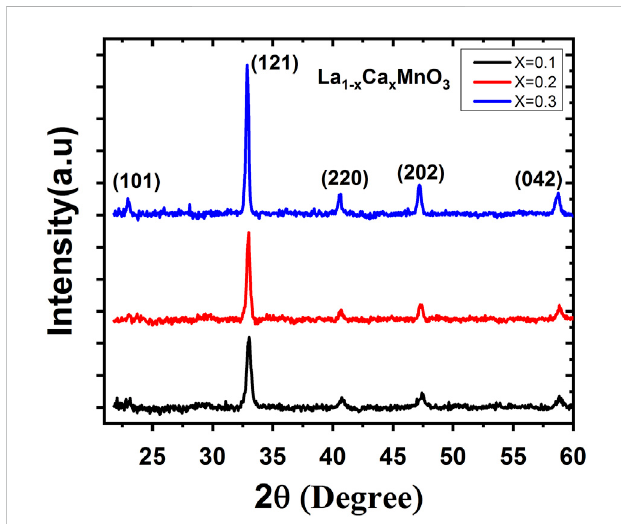
FIGURE 1 XRD pattern of La 1-x Ca x MnO 3 nanoparticles, where x = 0.1, 0.2, or 0.3.